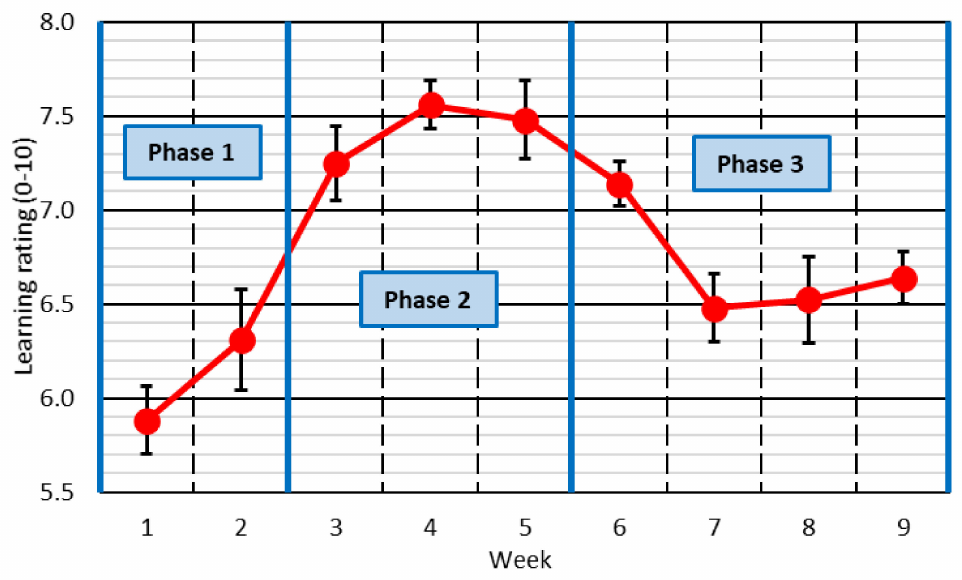
Figure 3. Learning rating throughout the